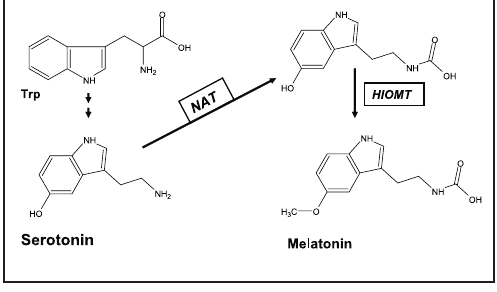
Fig. 2. Synthesis of melatonin. NAT = arylalcylamine N-acetyltransferase, HIOMT = hydroxyindole-